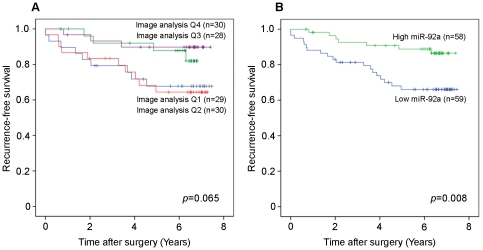
Recurrence-free survival among breast cancer patients according to miR-92a expression.
A) Tumours were divided into four groups based on the staining intensity of miR-92a and recurrence-free survival for the patients was determined, p = 0.065. B) Recurrence-free survival analysis after merging of tumours in Q1–Q2 and Q3–Q4, p = 0.008.